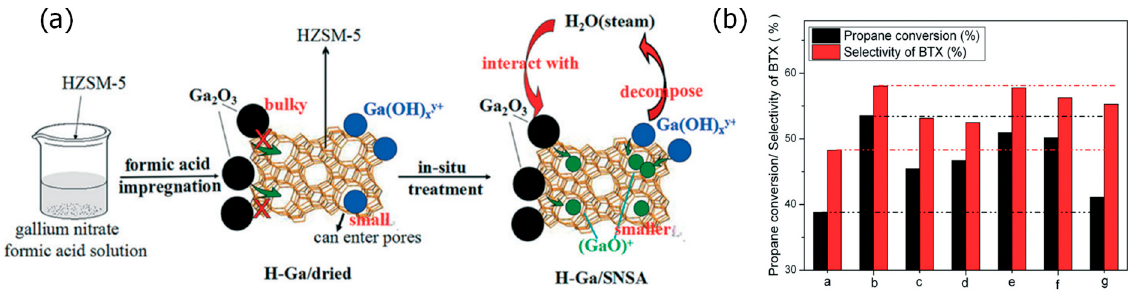
Figure 5. Ga/HZSM − 5 prepared by formic acid − assisted impregnation method with in situ treat ‐ ment ( a ), and their catalytic performance in propane aromatization ( b ). Reprinted with permission from ref. [87]. Copyright 2011 Royal Society of Chemistry.